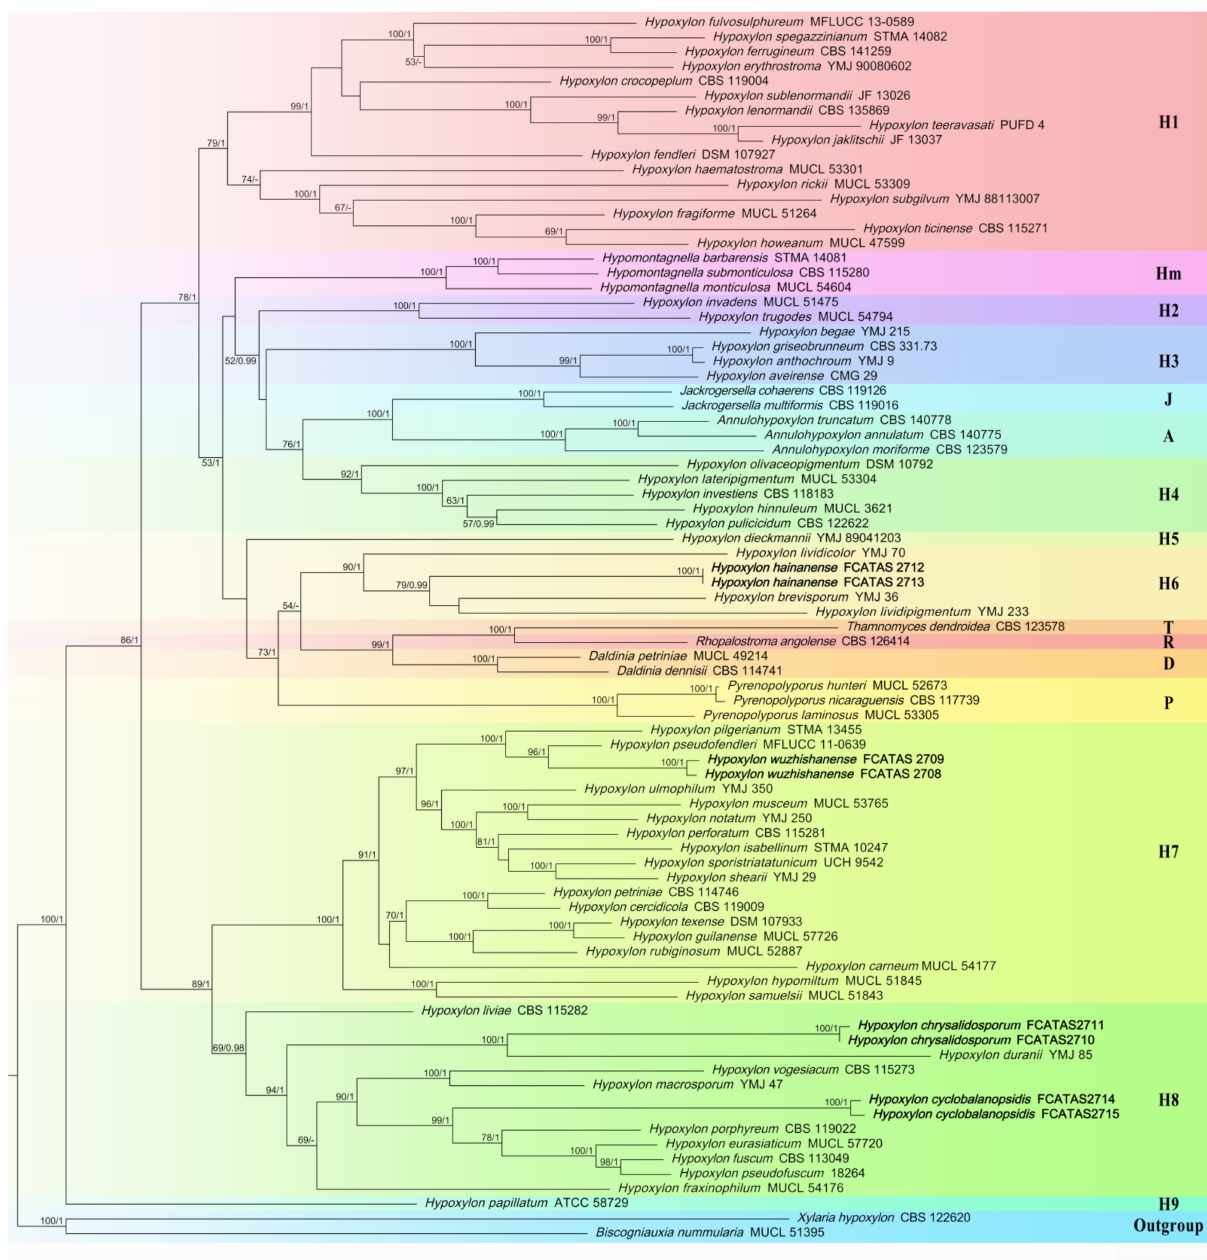
Figure 1. ML phylogram of the Hypoxylon species based on the multi-gene alignment of ITS–LSU– RPB2– β -tubulin. Support values of ML and BI analyses (bootstrap support ≥ 50%, posterior proba- bilities value ≥ 0.95) are labelled above or below the respective branches (ML/BI). New species are labelled in